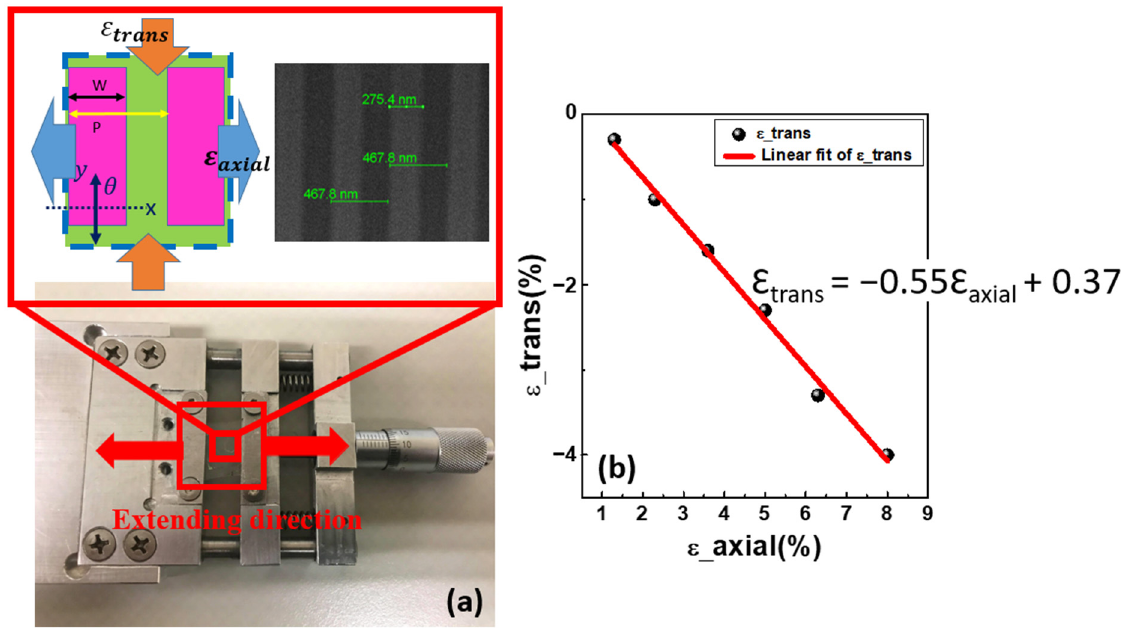
Figure 6. ( a ) Homemade stage that serves as the extending platform. ( b ) Poisson’s ratio calculation. The pattern’s lattice constant in this experiment is 470 nm, which increases as the pattern stretches. The extension of the lattice constant along the x-direction is measured by optical microscope and the strain percentage is defined as X (%) = (X − X 0 )/X 0 × 100%, where X 0 and X are the length of the original pattern bonded on the PDMS substrate and after deformation, respectively. In this experiment, the strain percentage reflects the relative deformation in the size of a single pattern, which is 30 × 30 µ m 2 . The period increases from 470 nm to 506 nm as the pattern’s strain increases to 8%, as seen in Table 1. In addition, as the strain of the pattern decreases to 1.6%, the period decreases from 470 nm to 462 nm. The pattern’s period is linearly proportional to the pattern’s relative deformation, according to the measurements. Table 1. Estimating the period of the 1-D PhC with different strains from the optical microscope. Strain